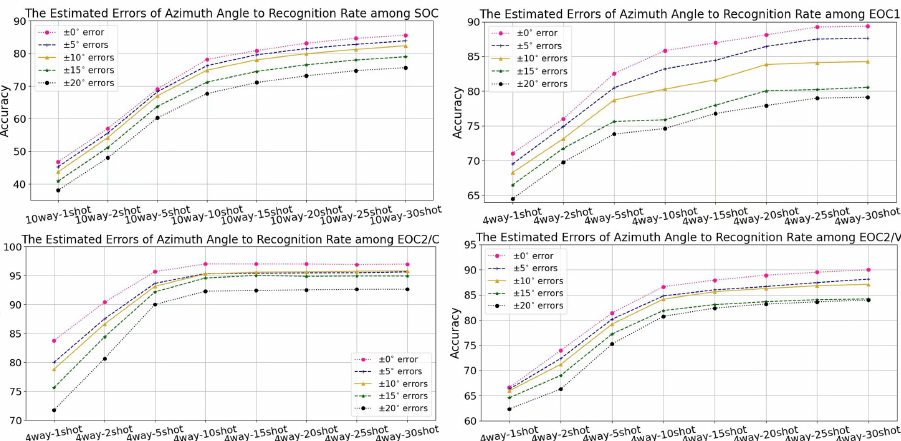
Figure 3. The line charts of estimated azimuth-angle errors to the accuracy among SOC and